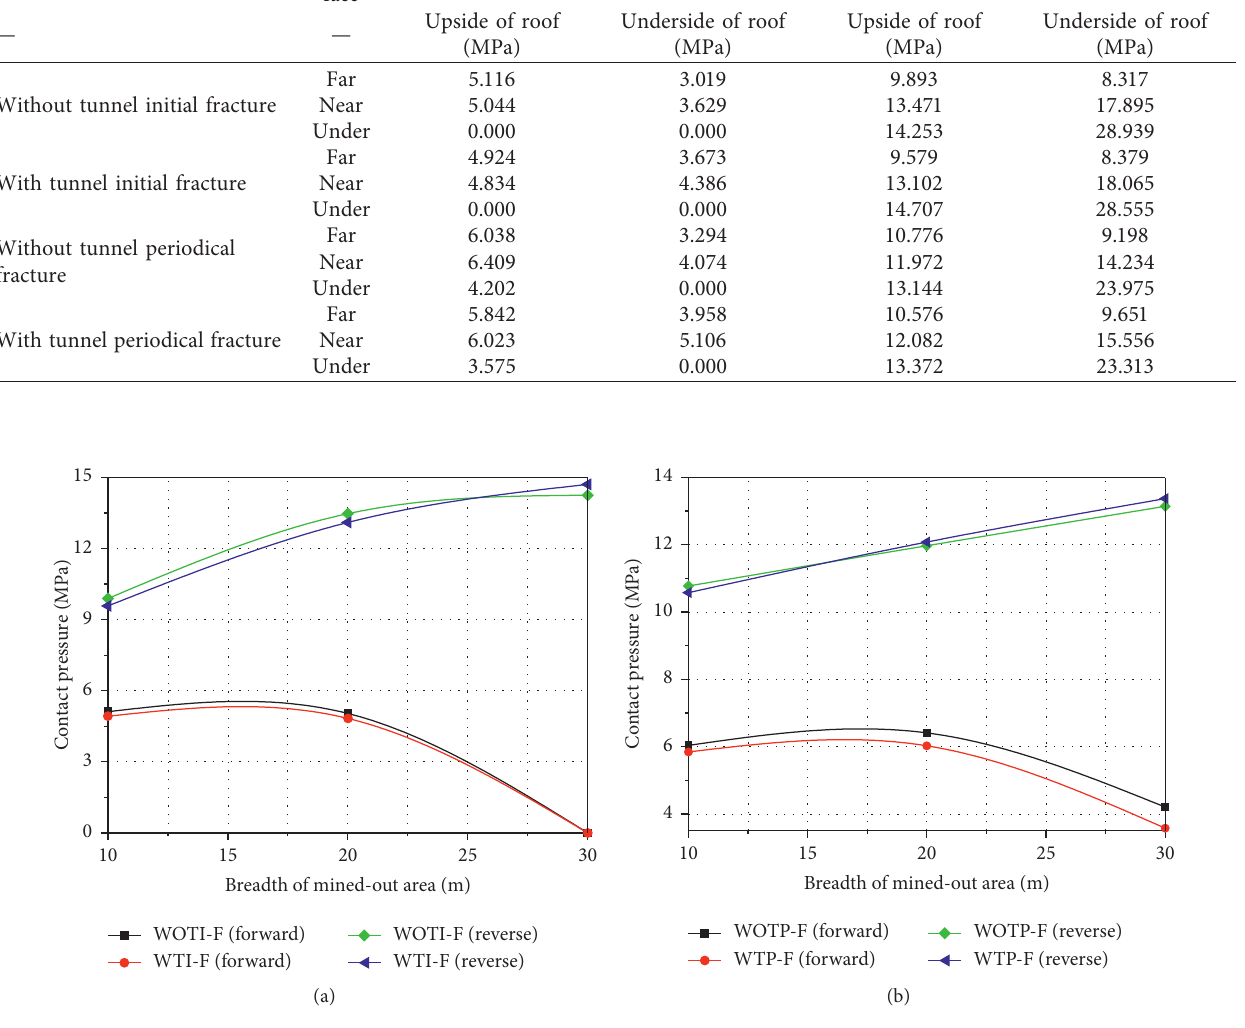
Figure 26: The change of contact pressure of upside fault along with the breadth of mined-out area (WOTI-F denotes without searching tunnel initial fracture, WTI-F denotes with searching tunnel initial fracture, WOTP-F denotes without searching tunnel periodical fracture, and WTP-F denotes with searching tunnel periodical fracture). (a) Initial fracture. (b) Periodical